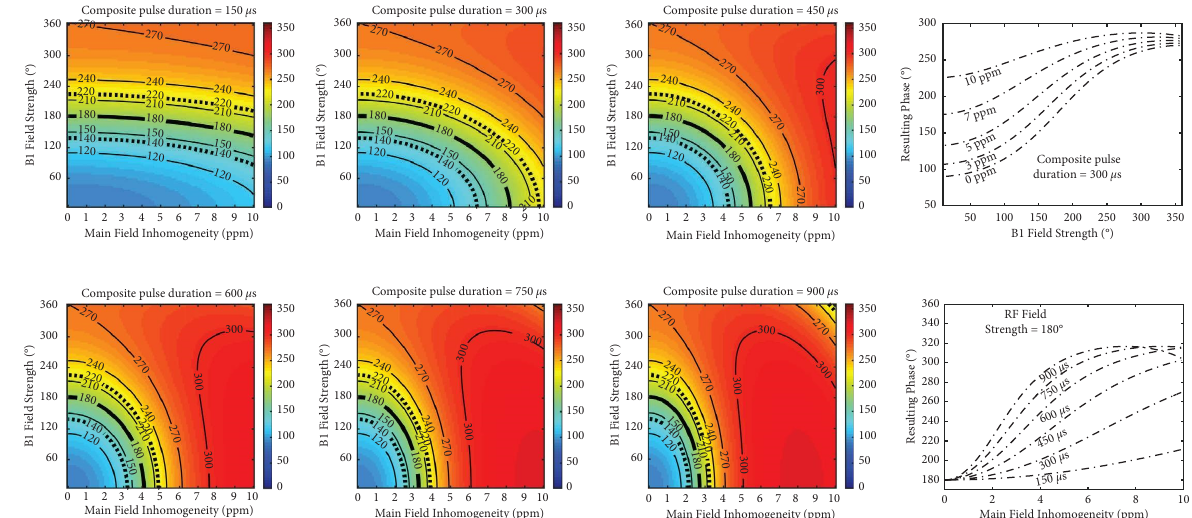
Figure 3: Phase diferences of two MR images obtained from two composite RF pulse sequences according to B homogeneity, and composite RF pulse duration. Tis contour graph was obtained by solving the Bloch equation numerically.